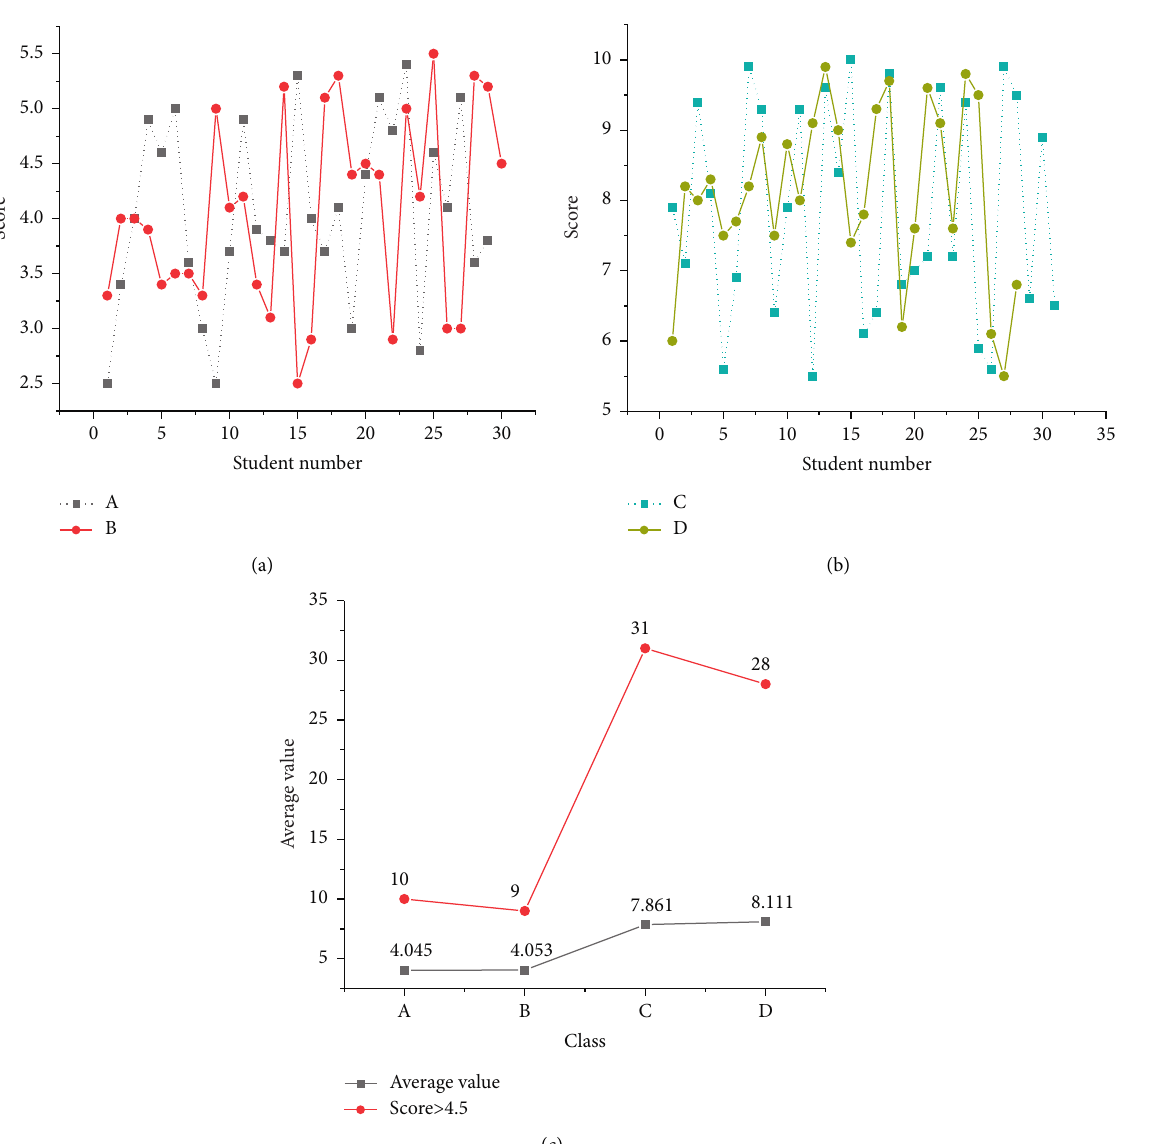
Figure 12: Statistics of students’ scores: (a) teaching mode in the traditional classroom; (b) teaching mode in digital twin classroom; (c) average